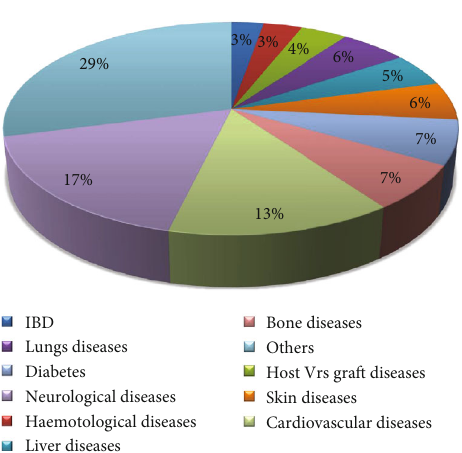
Figure 4: The percentage distribution of MSC-based clinical trials on some selected conditions. Some of the most registered MSC-based clinical trials include neurological diseases (17%), cardiovascular diseases (13%), bone diseases, and diabetes (7% each). IBD contributes approximately 3% to MSC-based clinical trials.